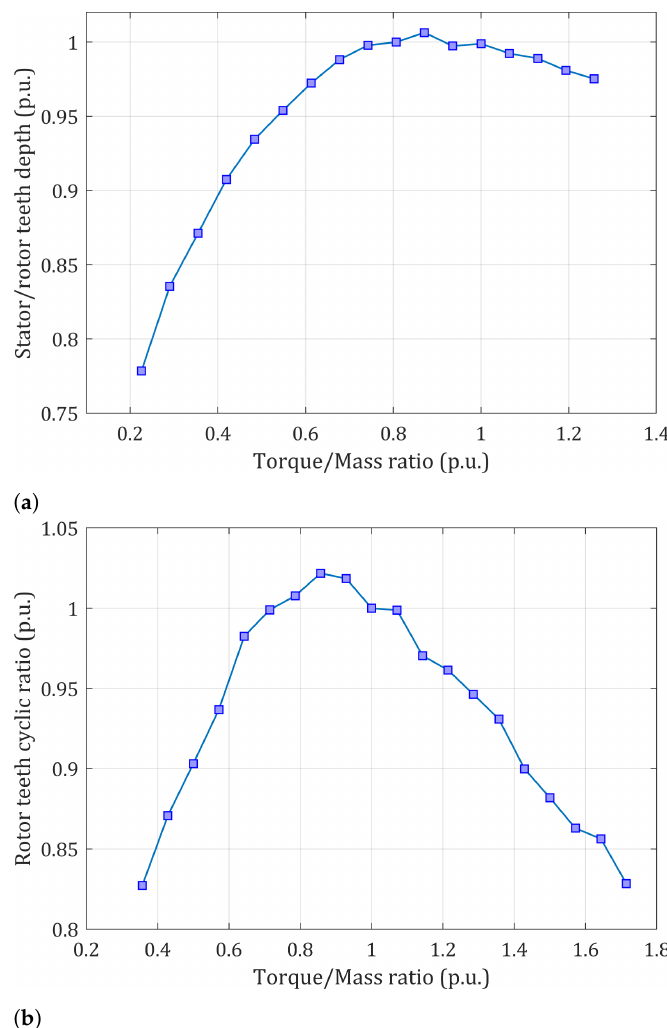
Figure 11. Stator and rotor teeth geometry impact on torque-density ( a ) teeth depth and ( b ) teeth